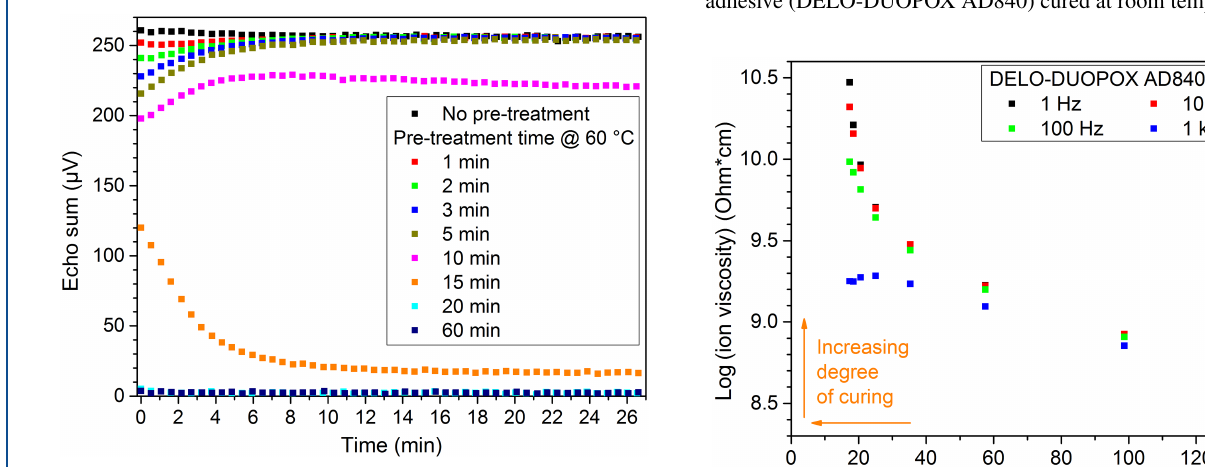
Figure 18. Curing of UP resin at room temperature: the samples were pre-treated at 60 ◦ C in a furnace for different times before measurement.